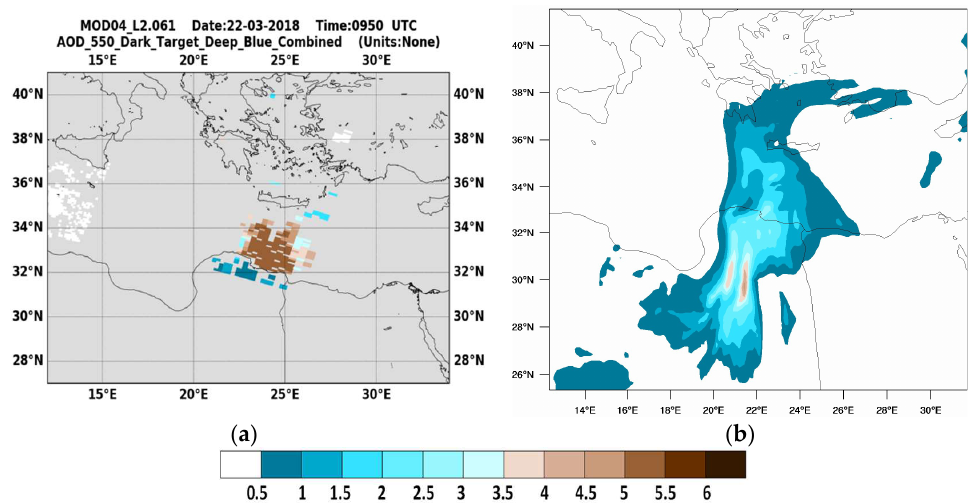
Figure 7. ( a ) MODIS AOD (unitless) at 0950 UTC; ( b ) WRF-Chem AOD (unitless) at 1000 UTC,